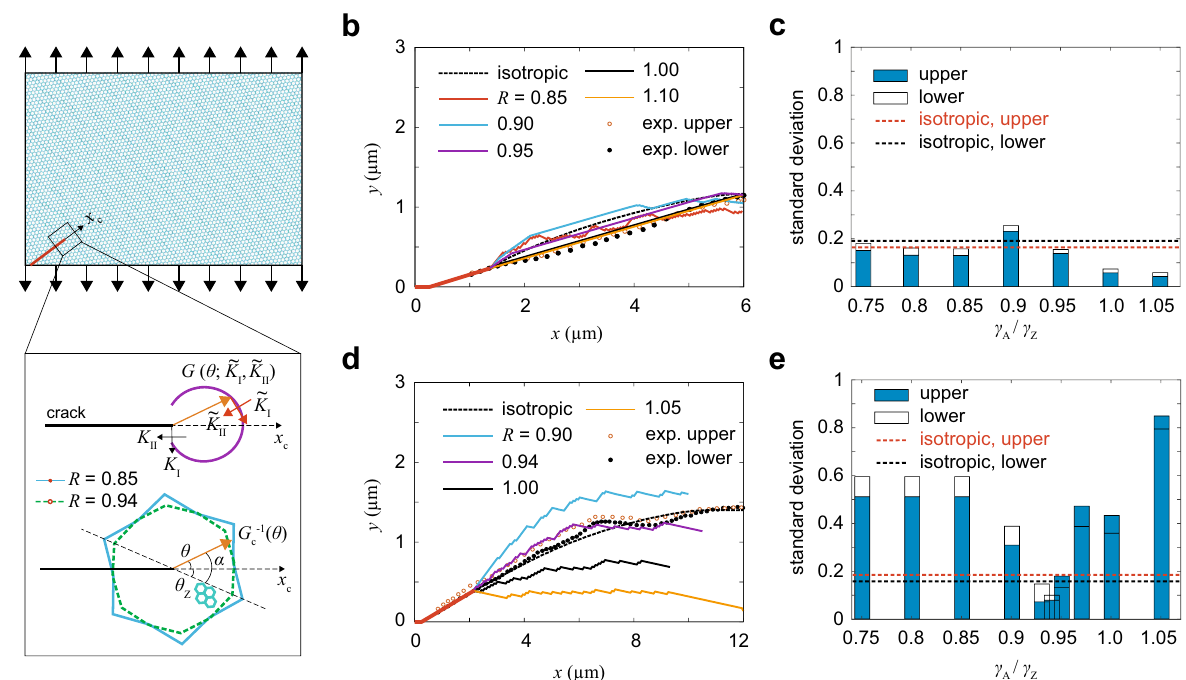
Fig. 2 XFEM models and simulation results. a Sample geometry, loading conditions, local energy release rate ( G ( θ )), and the anisotropy in fracture ð θ Þ , plotted for two values across R = 0.87) at the crack tip. The stress intensity factors K toughness ( G (cid:3) 1 c b - e Crack-path predictions and standard deviations measured from the experimental data for Sample 1 ( b , c ) and Sample 2 ( d , e ), respectively. The results are obtained by varying R = G A / G Z in the range of [0.74,